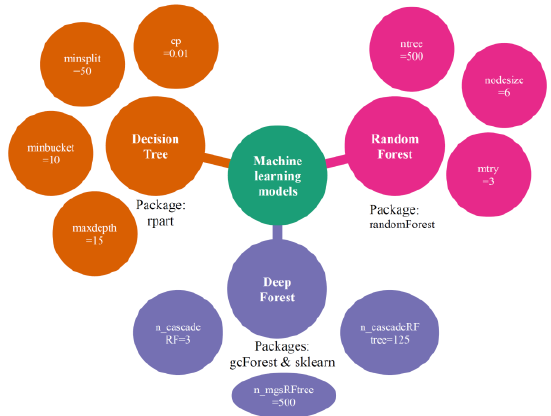
Figure 2 . Packages and selected parameters used for the